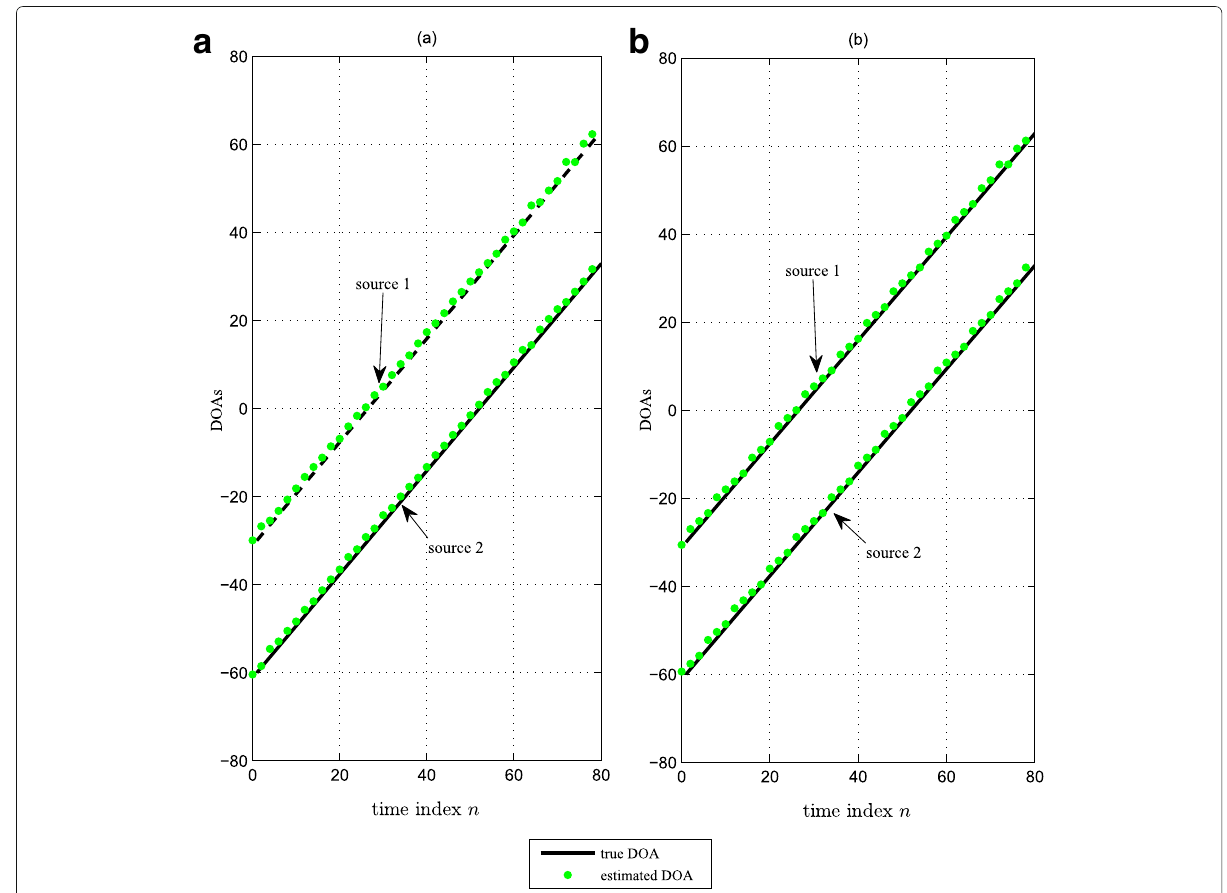
Fig. 5 True DOAs and their estimates with QPSK, K = 2 sources, N = 1, ˙ θ 1 = ˙ θ 2 = 1.175° / sample , R = 100, N a = 16 and SNR=15 dB: ( a ) AF-based